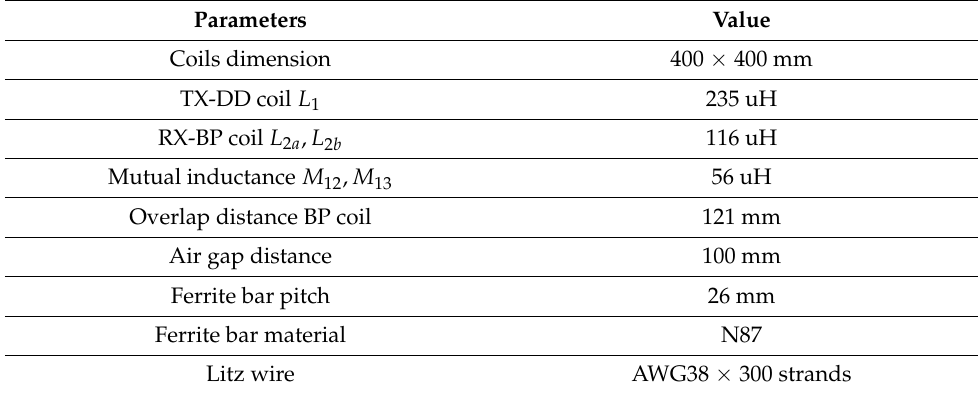
Figure 23. Coils design and simulation: ( a ) a 3D model of coil system, ( b ) flux path of DD-BP coils, and ( c ) estimated decoupling overlap position by simulation. Table 9. Design specifications of coil